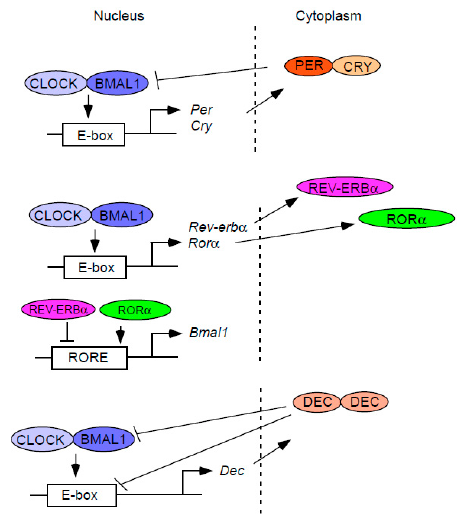
Figure 1. The core molecular mechanism of the circadian clock. The molecular clock is composed of diverse autoregulatory feedback loops. The core components of the molecular clock, CLOCK and BMAL1, activate the transcription of repressor clock genes such as Per , Cry , Rev-erb α , and Dec . CLOCK and BMAL1 also activate the transcription of inducer Ror α . The protein products of these repressor or inducer genes inhibit or promote their own transcription in distinct ways, thus forming various feedback loops that create a coordinated circadian rhythm at the gene expression level.